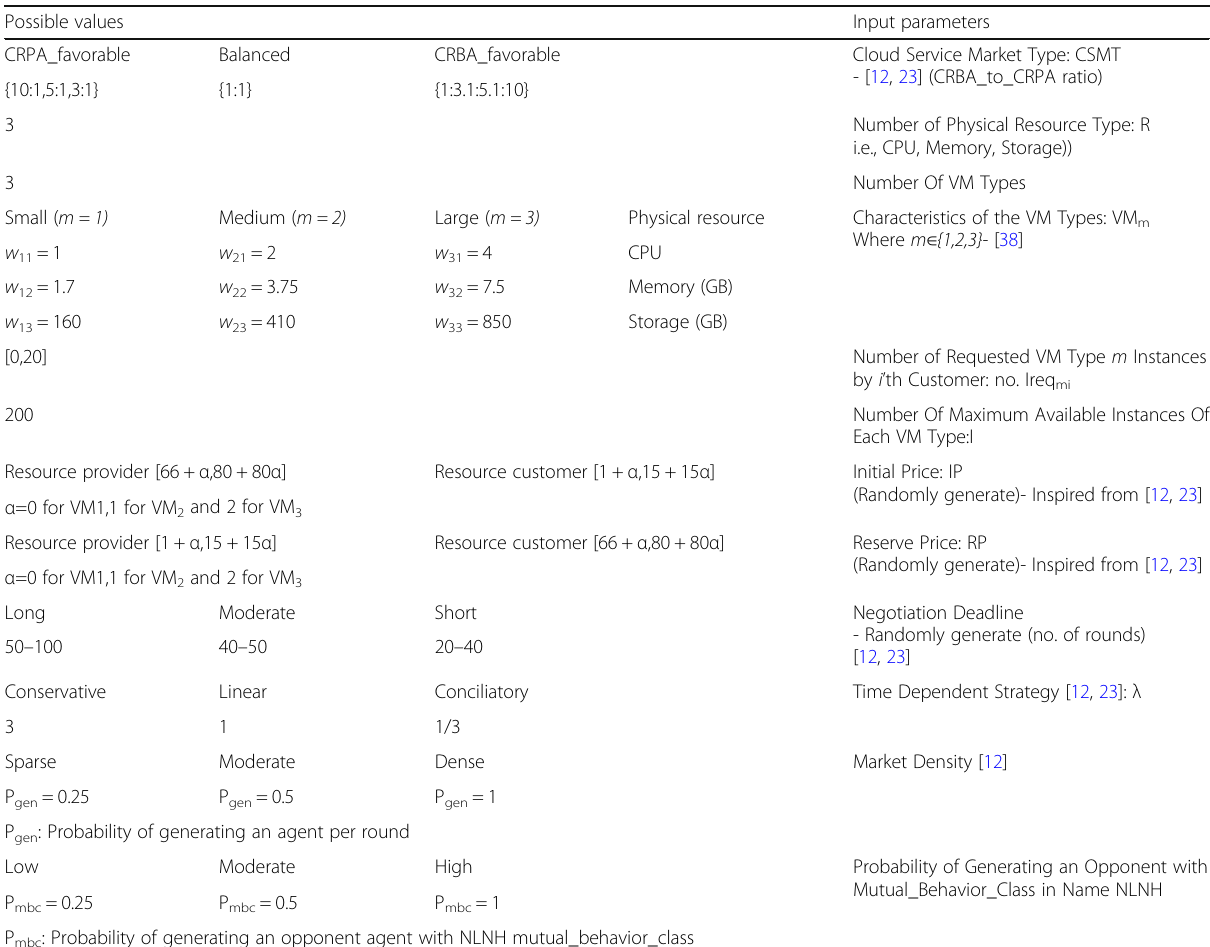
Table 4 Input parameters to configure the simulation environment and their relative values Possible